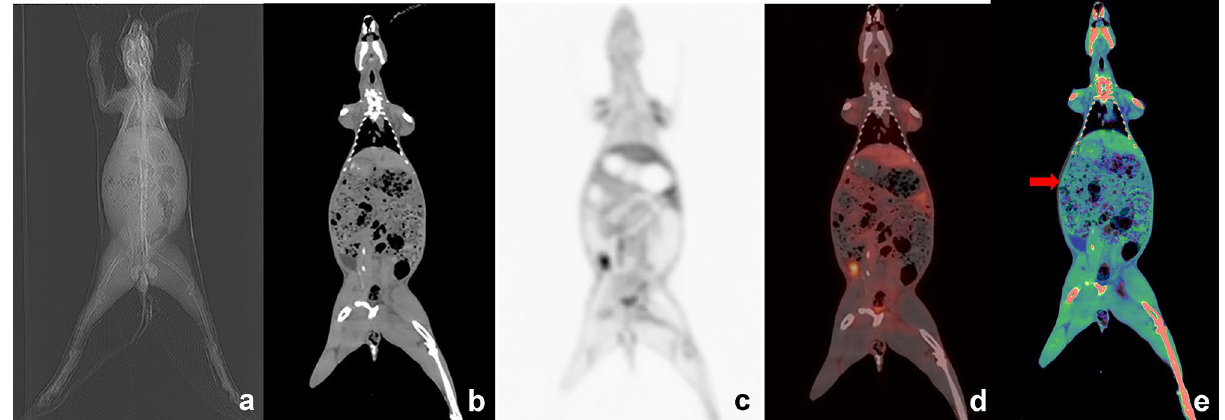
Figure 3. PET-CT scan for a rabbit restrained by the novel fixator. (a) : The CT localization image showed the overall morphology of the fixator and the rabbit under the X-ray; the rabbit cannot move when it is restrained. (b) : The coronal CT scan indicated that each organ of the rabbit showed well, with no metal or motion artifacts. (c) : The PET image showed the 18 F-FDG images of all the organs of the rabbit that was restrained by the fixator (time point: 30 min). (d) : The PET/CT fusion image had perfect image quality. (e) : The fusion image of the dual- phase CT(before and after PET scanning (Pseudo color)) showed that the dual-phase CT images matched well except for a slight ghosting of the abdomen (red arrow).